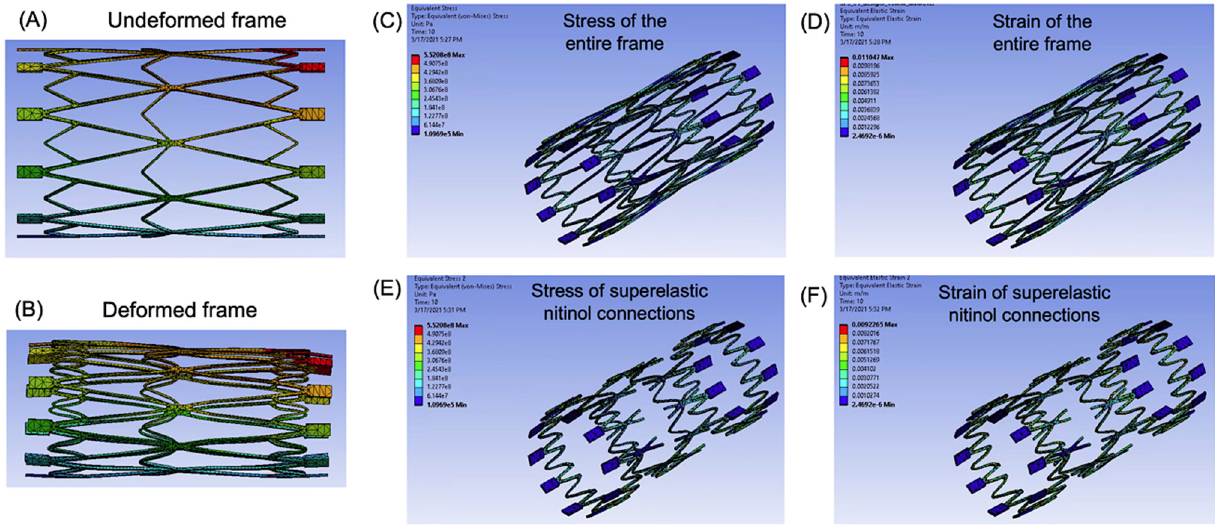
Figure 10. Stress and strain computational analysis of the pediatric valve: ( A ) undeformed valve shape, ( B ) deformed valve shape, ( C ) stress of the entire frame after deformation, ( D ) Von Mises strain in the frame after deformation, ( E ) stress of nitinol connection regions, and ( F ) Von Mises strain of nitinol connection regions.